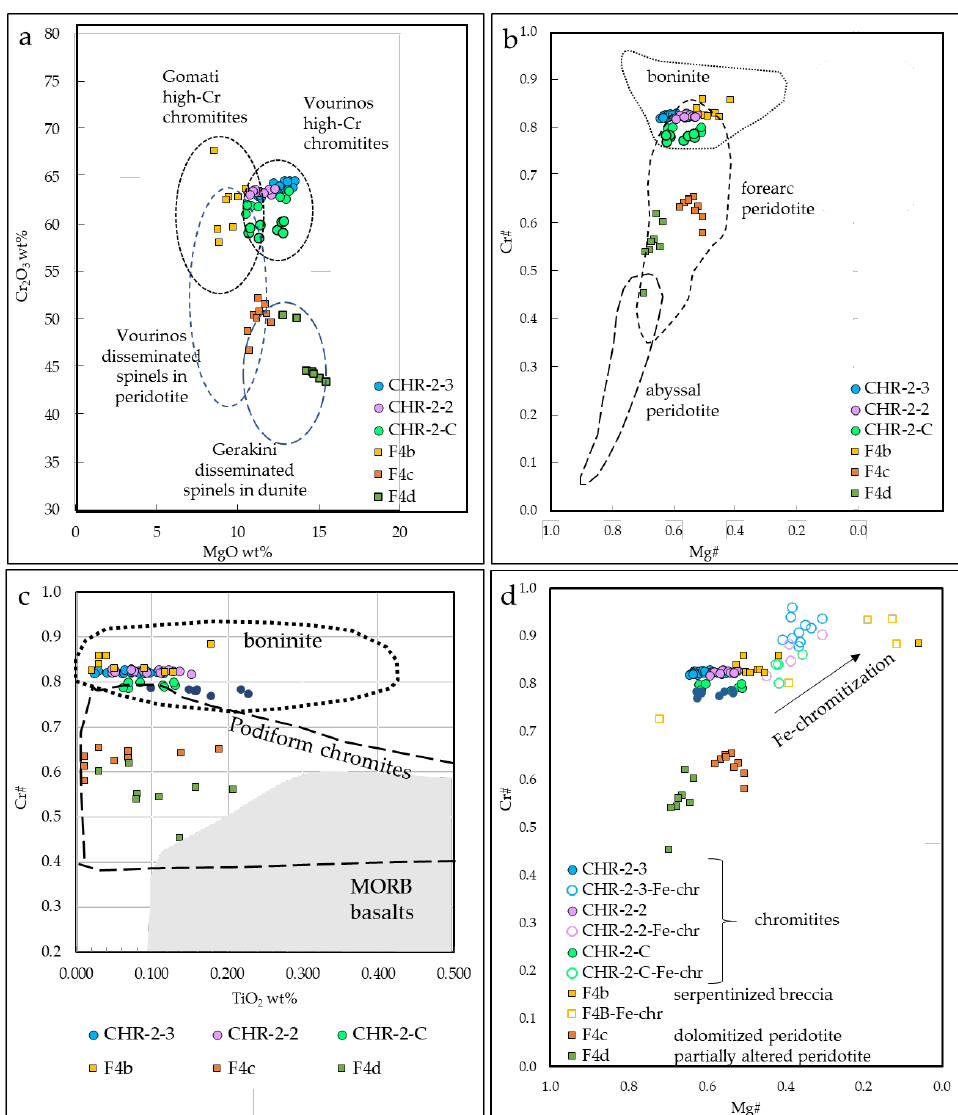
Figure 9. ( a ) Cr 2 O 3 vs. MgO (wt%) of chromite cores. Compositional fields: Gomati high-Cr chromitites [30,31], Vourinos high-Cr chromitites [28], Vourinos disseminated spinels in dunite [27] Gerakini disseminated spinels in dunite [11]; ( b ) Cr# vs. Mg# of chromite cores. Compositional fields are from [35,38]; ( c ) Cr# vs. TiO 2 (wt%) of chromite cores. Compositional fields from [48]; ( d ) Cr# vs. Mg# of chromite cores and Fe-chromite rims.